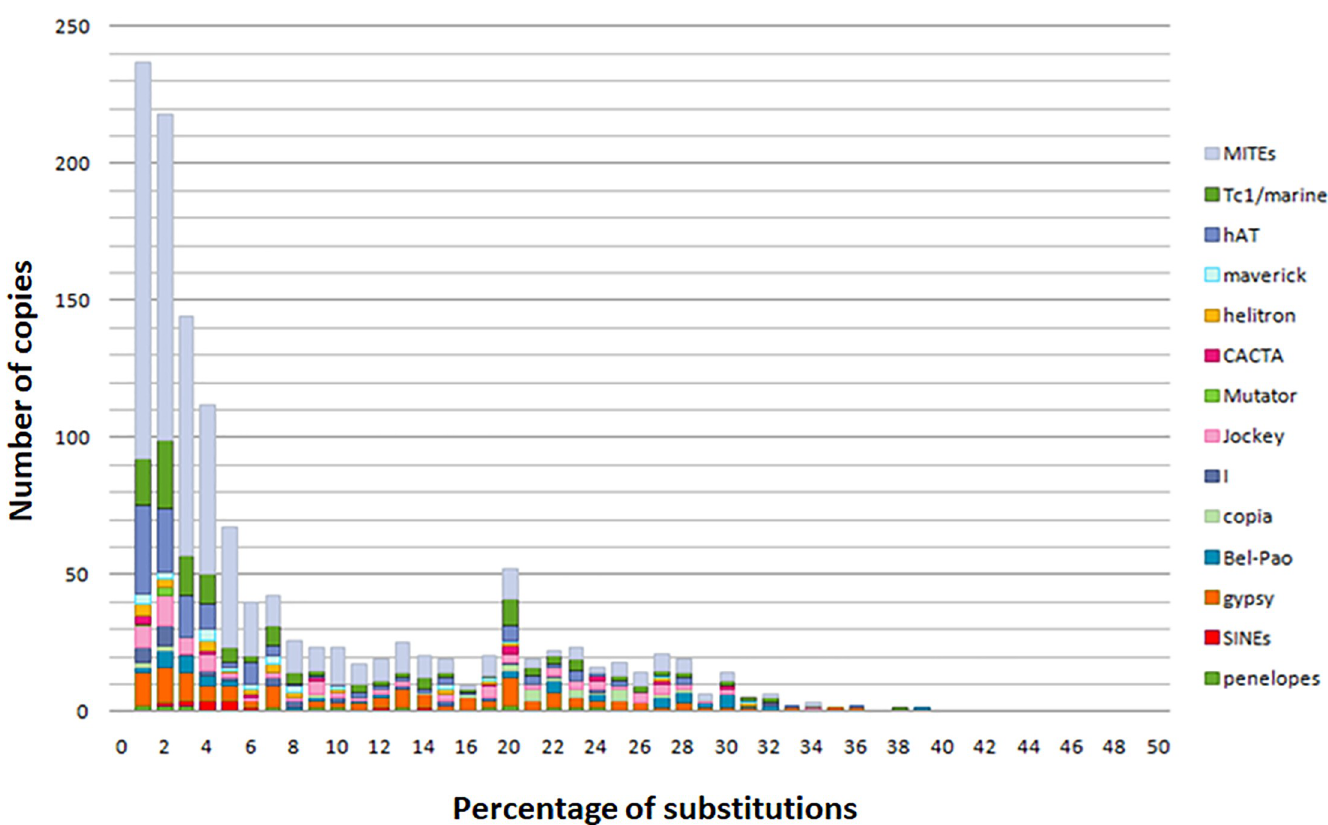
Fig 5. Estimate of MITEs and TEs transposition events in Mayetiola destructor genome. The age of TEs is given as the percentage of substitutions from their consensus sequences shown in the x-axis. Recent events of transposition have low substitution levels. The y-axis shows the TEs’ copy number. The age distributions suggest dominance MITEs activity between 1 and 6% of